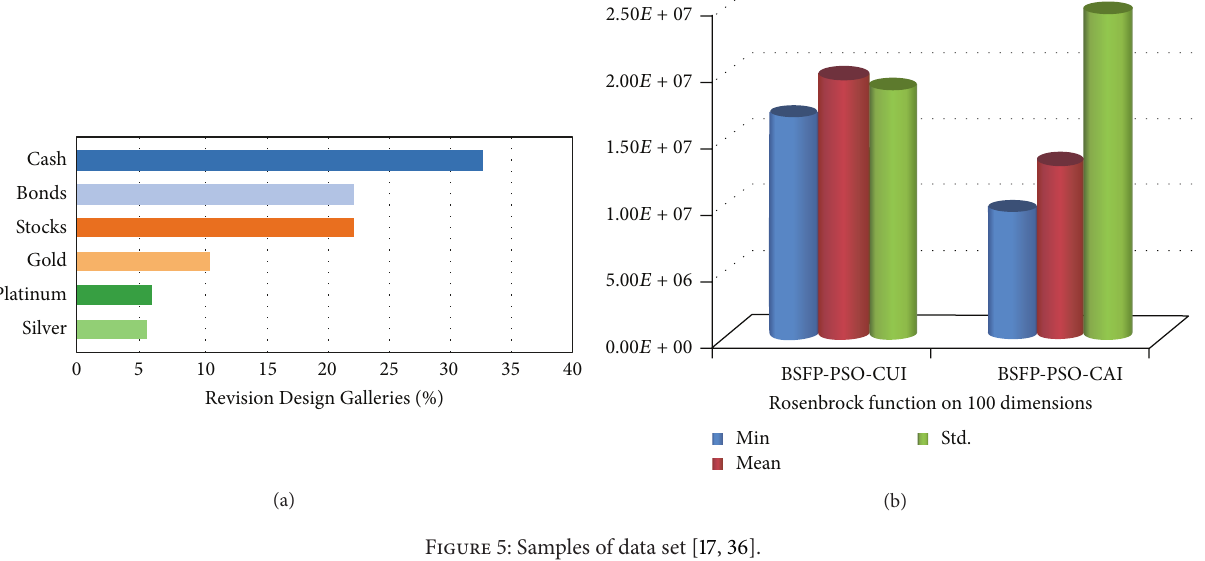
Figure 5: Samples of data set [17,